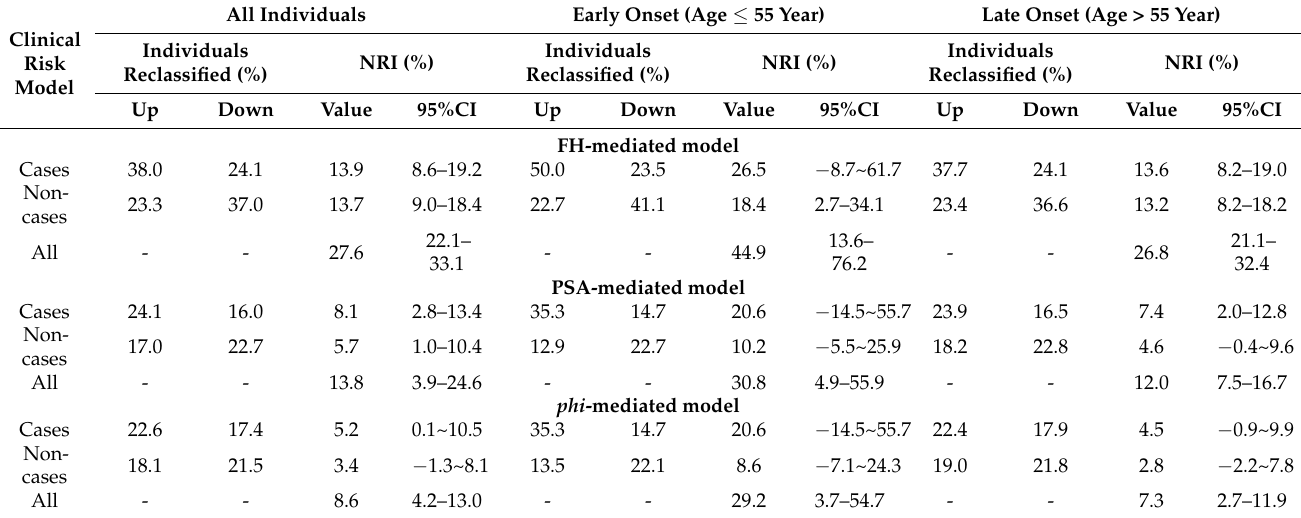
Table 4. NRI with the addition of the PRS to different clinical risk models across age-onset